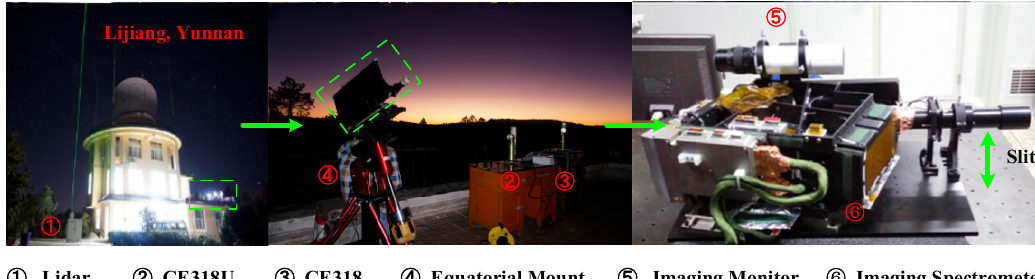
Figure 1. Observation site, atmospheric characterization tools and structure chart of the ground-based observation system. ( 1 – 3 ) are used for extinction correction, and the observation system composed of ( 4 – 6 ) is used to obtain the imaging photometric observations of the Moon.